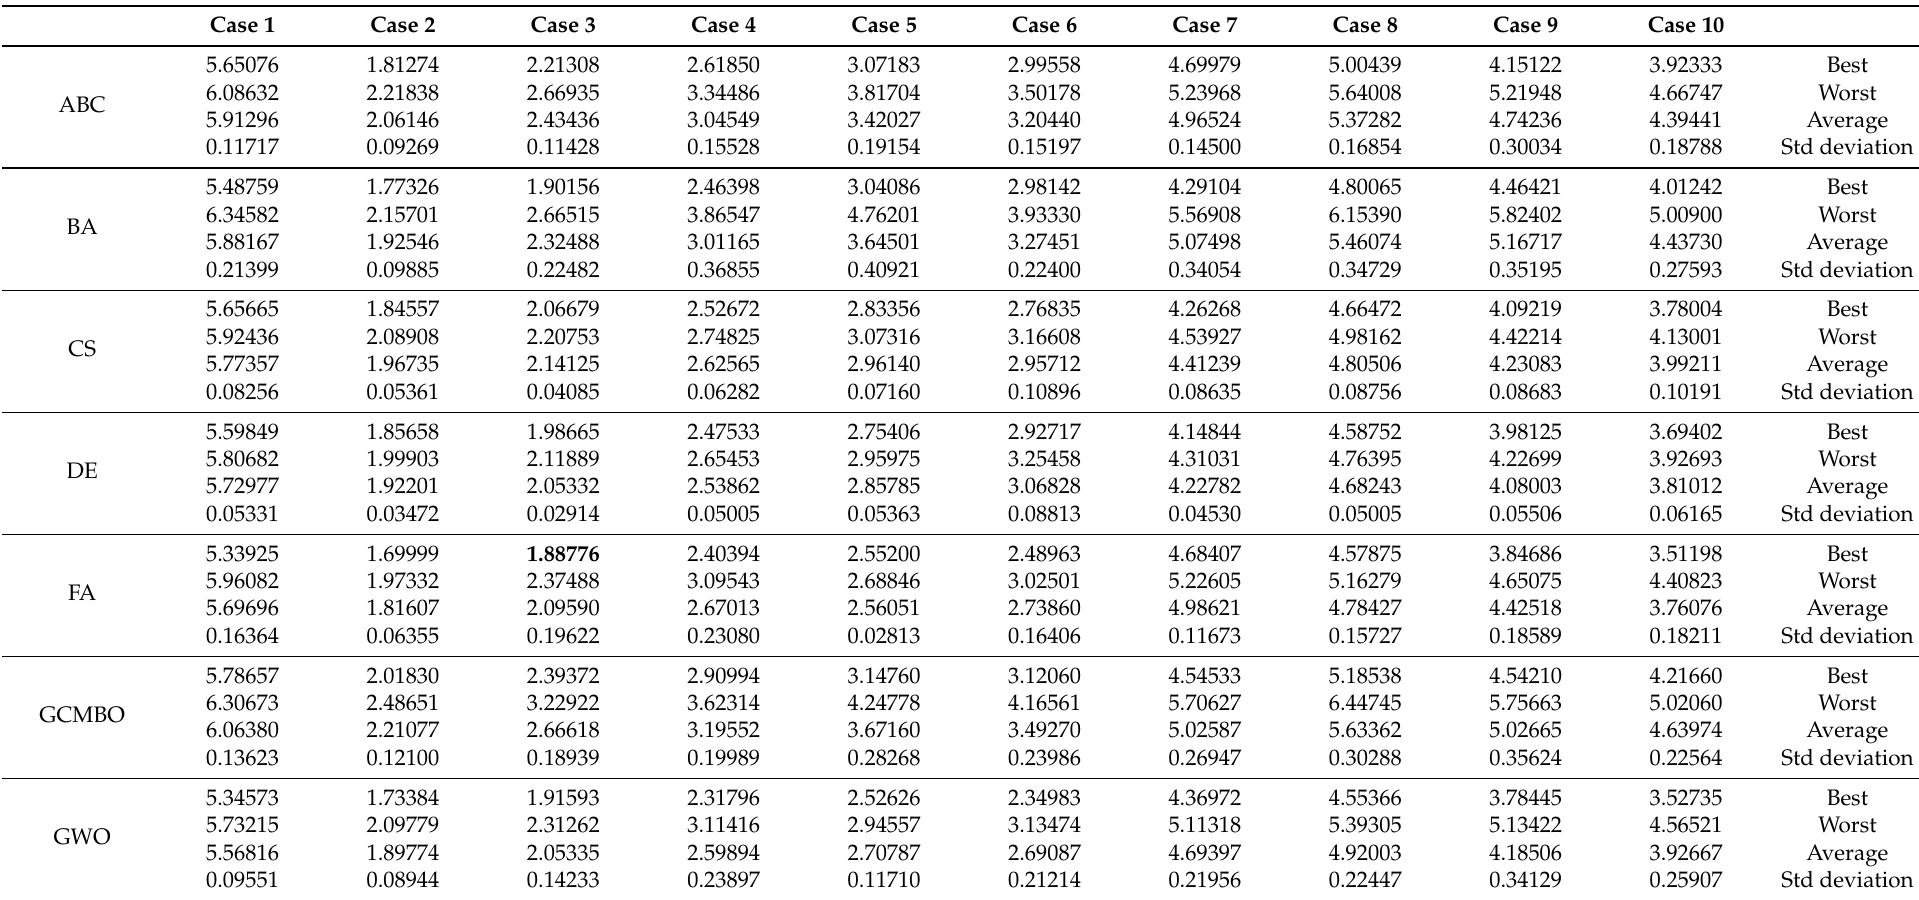
Table 3. Performance comparison of different swarm intelligence algorithms for medium-scale UCAV path-planning. The best, worst, average and standard deviation over 25 runs of each algorithm for ten cases are provided. The best values are in